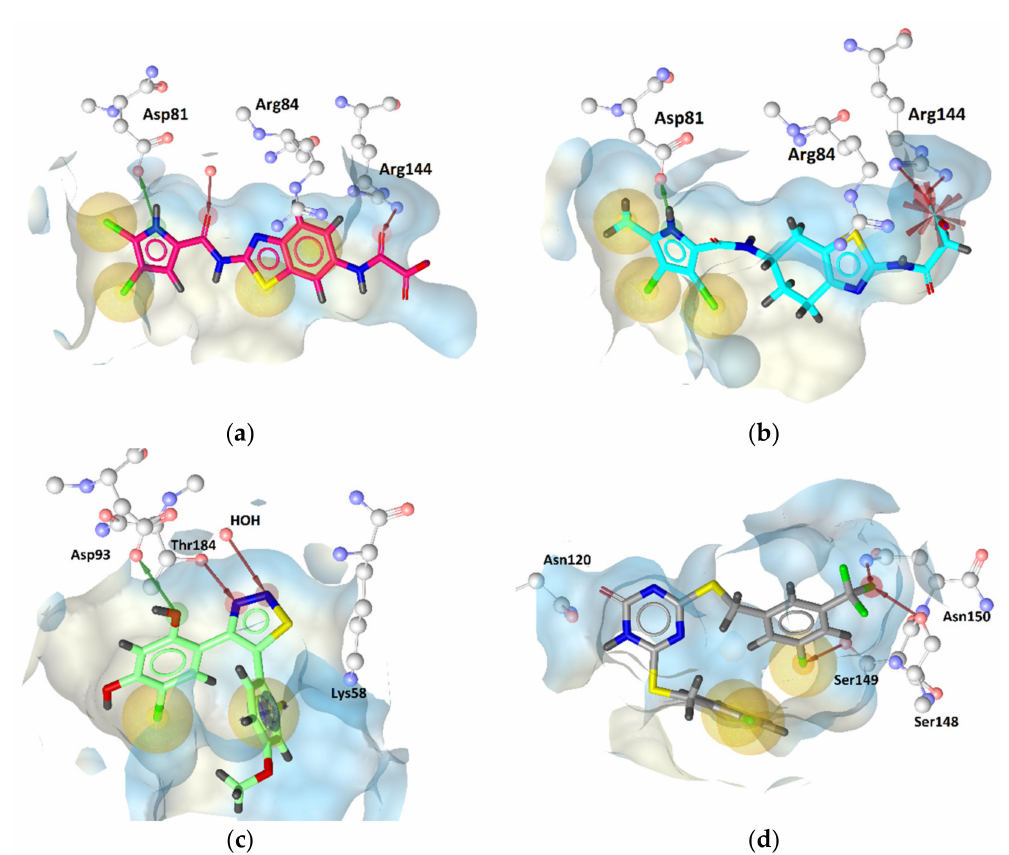
Figure 16. Docking binding modes of ( a ) compound 1 , ( b ) compound 2 in the GyrB, ( c ) compound 3 in the Hsp90, and ( d ) compound 5 in the TopoII ATP-binding